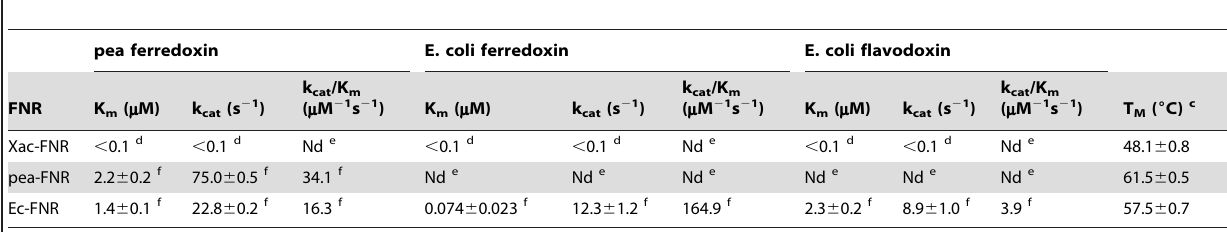
Table 2. Kinetic parameters a for cytochrome c reductase with pea ferredoxin, E. coli flavodoxin, and E. coli ferredoxin, and the melting temperatures of thermal unfolding transitions for Xac-FNR, pea-FNR and Ec-FNR